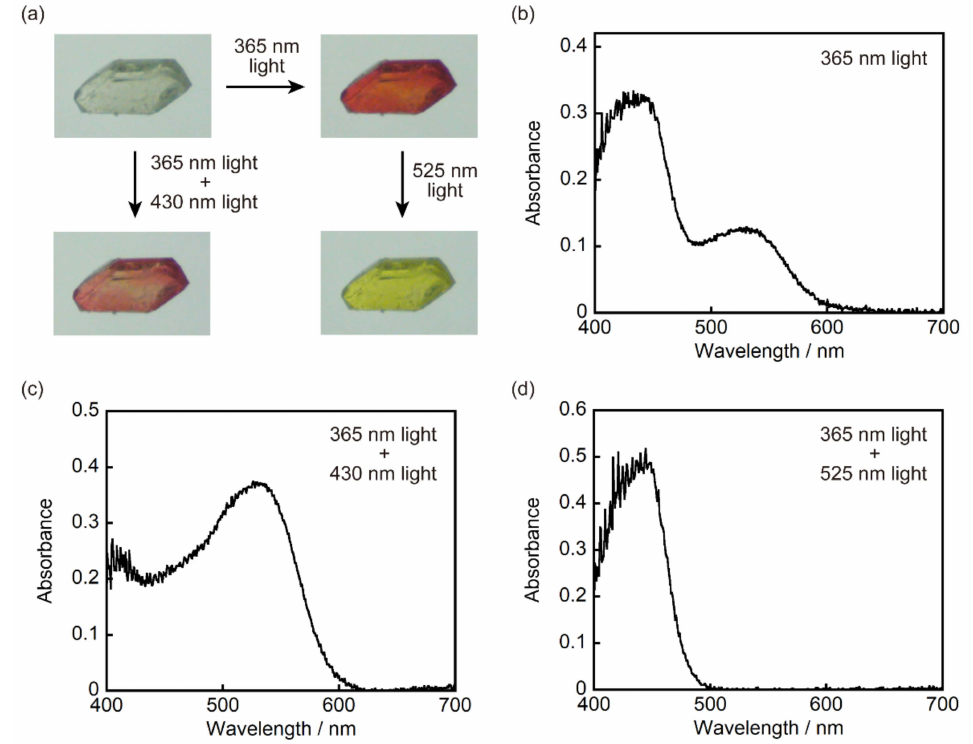
Figure 5. ( a ) Photographs of photoinduced color changes of a two-component mixed crystal with a composition ratio of 1a : 2a = 85:15 (entry 2 in Table 2). Absorption spectra of the two-component crystal irradiated with 365 nm light ( b ), irradiated with both 365 nm and 430 nm light ( c ), and irradiated with both 365 nm and 525 nm light ( d ). The absorption spectra were measured on ( − 1 1 0)